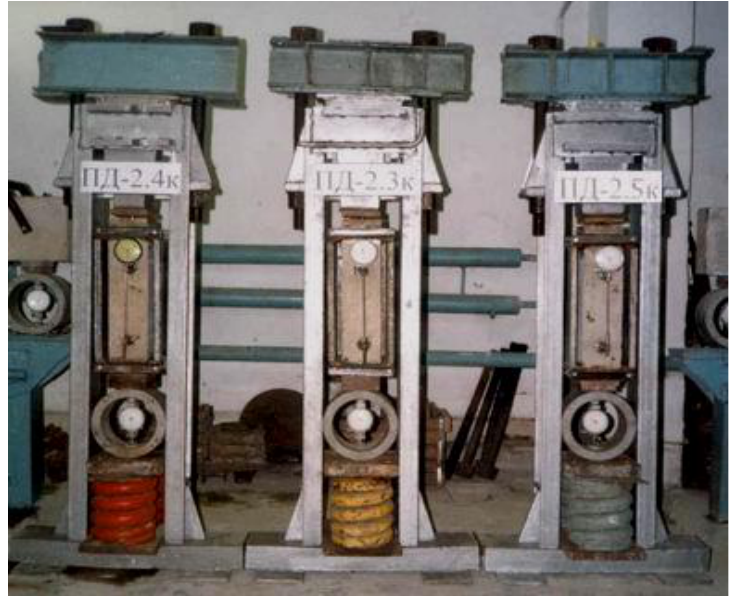
Figure 4. Prisms subjected to long-term loading before the experiment.